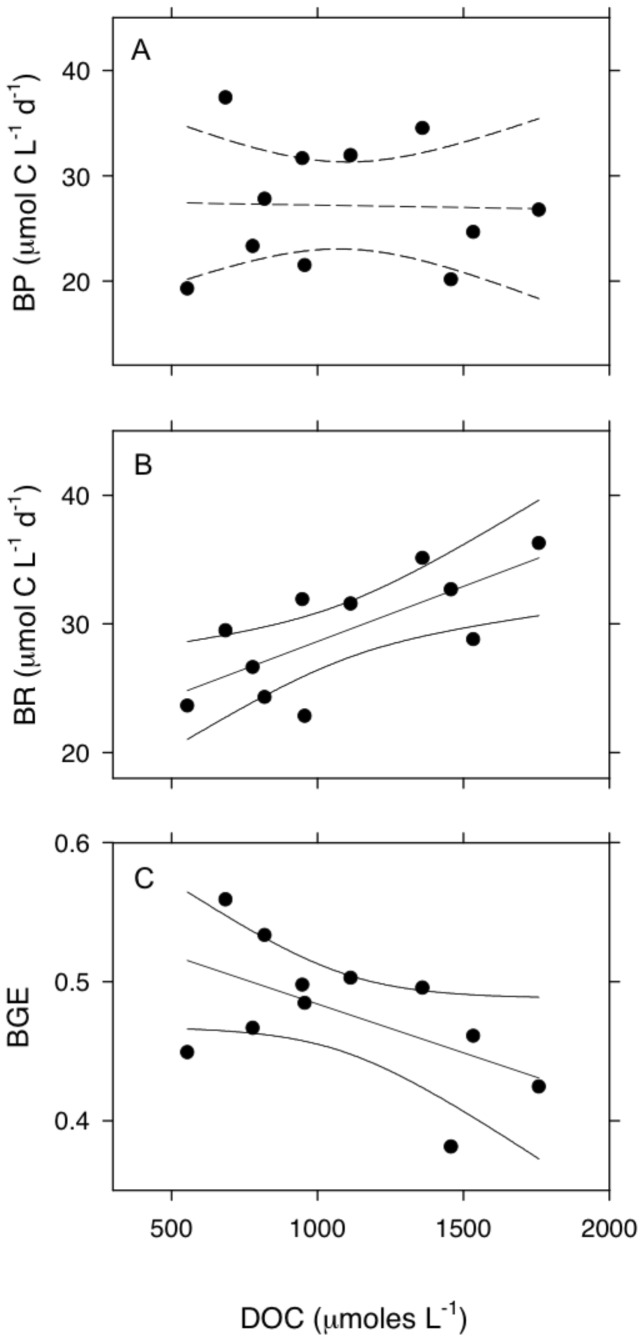
Microbial metabolism along a Super Hume gradient.We created a DOC gradient in a set of experimental ponds by altering the supply rate of Super Hume. There was no relationship between bacterial productivity (BP) and DOC (A), but bacterial respiration (BR) significantly increased (B) and bacterial growth efficiency (BGE) significantly decreased (C) along the DOC gradient. Regression lines represent predicted values and 95% confidence intervals for significant (solid lines) and non-significant (dashed lines) models.